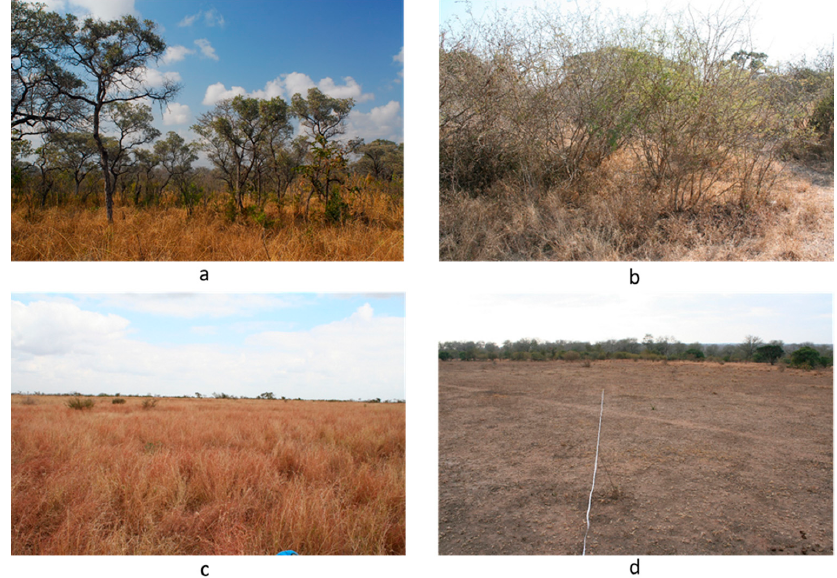
Figure 2. Examples of woodland and grassland VHR land cover classes: ( a ) trees; ( b ) shrubs; ( c ) long grass and ( d ) sparse grass.